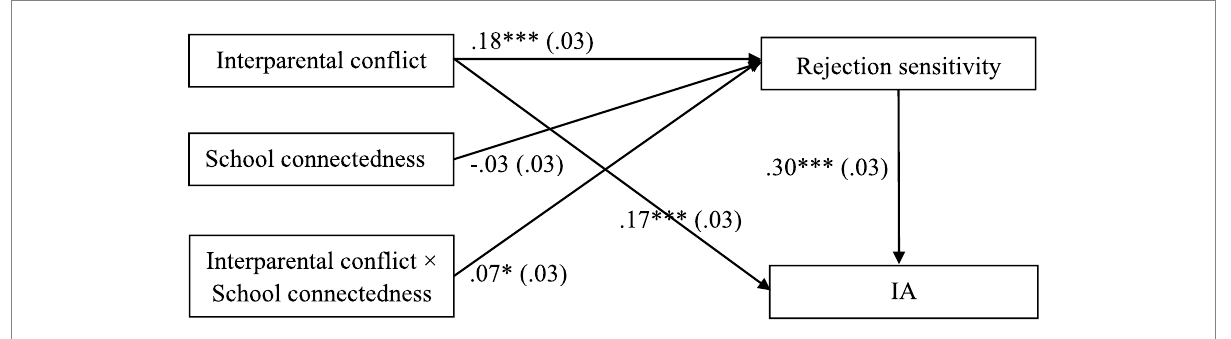
FIGURE 2 Model of the moderating role of school connectedness in the indirect relationship between interparental conflict and IA. Values are standardized coefficients. * p < 0.05, and *** p <